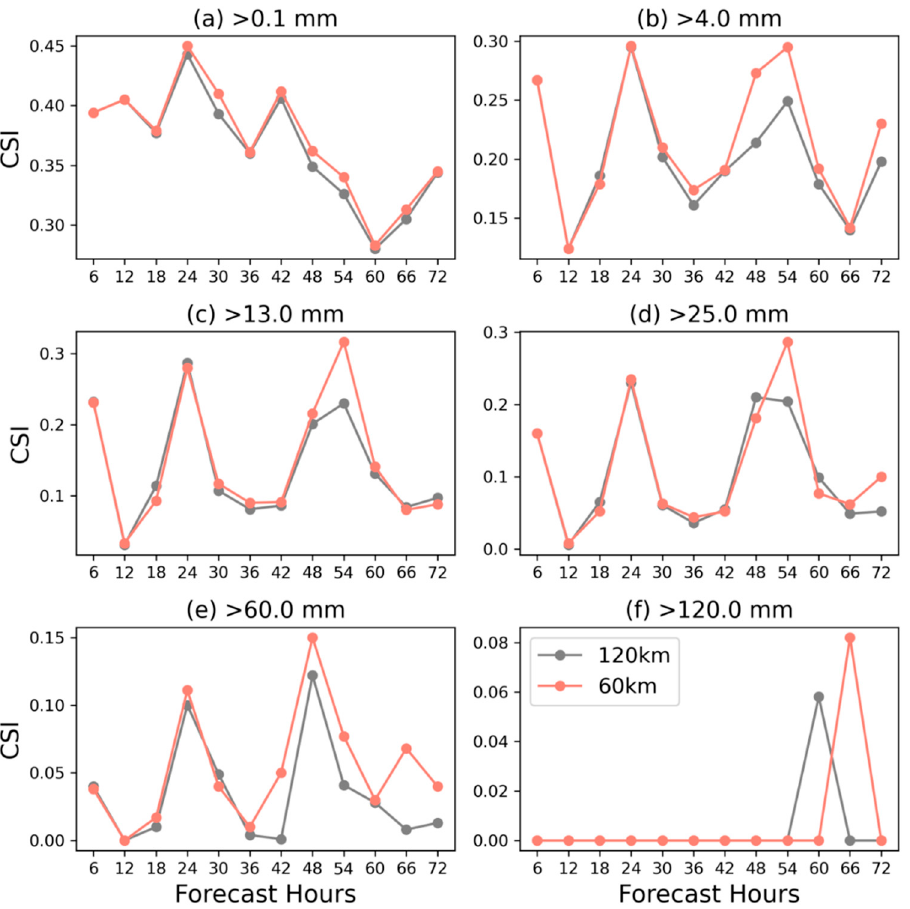
Figure 5. The CSI variations of 6 h accumulative rainfall in the 0–72 h forecasts of the EXP_WV9 at the 120 km (grey) and 60 km (light-red) thinning grid, for a threshold of ( a ) 0.1 mm, ( b ) 4 mm, ( c ) 13 mm, ( d ) 25 mm, ( e ) 60 mm, and ( f ) 120